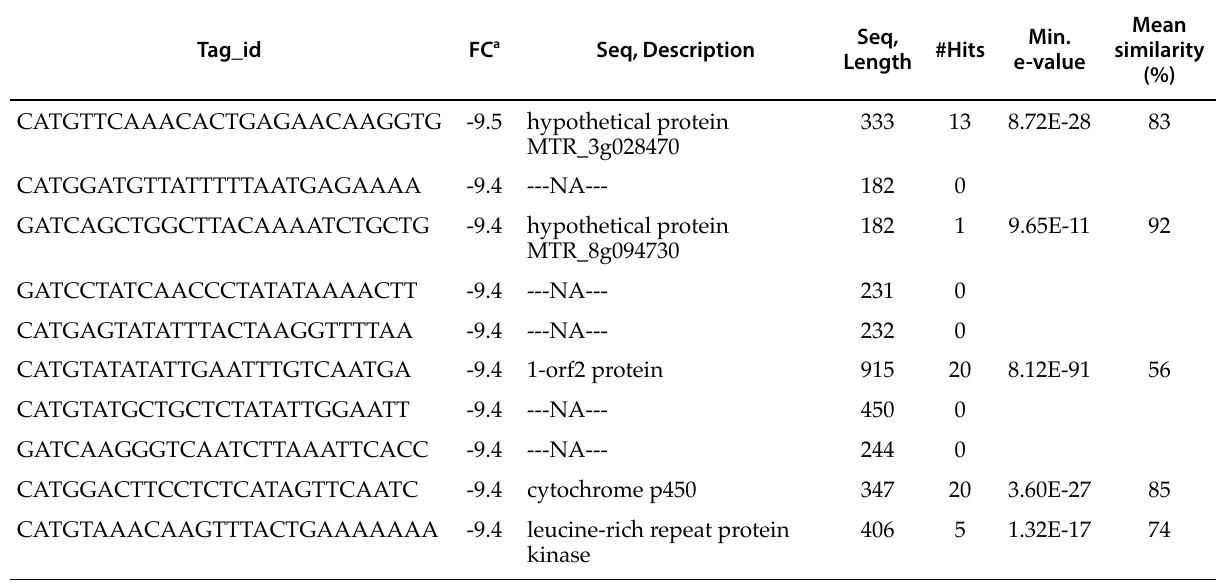
Table 2. Continues.